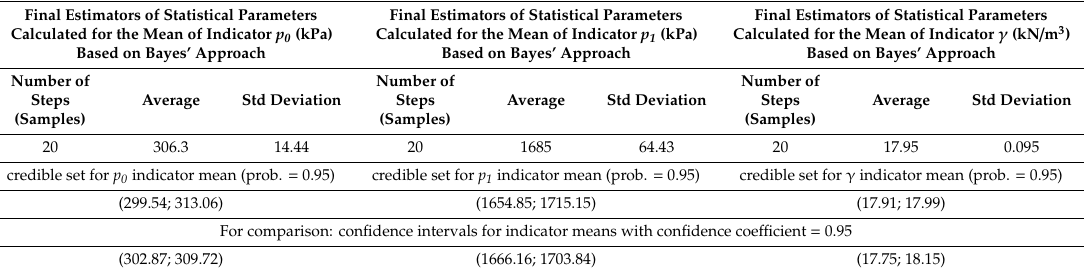
Table 6. Final results for indicators p 0 , p 1 , and γ in the sand layers.